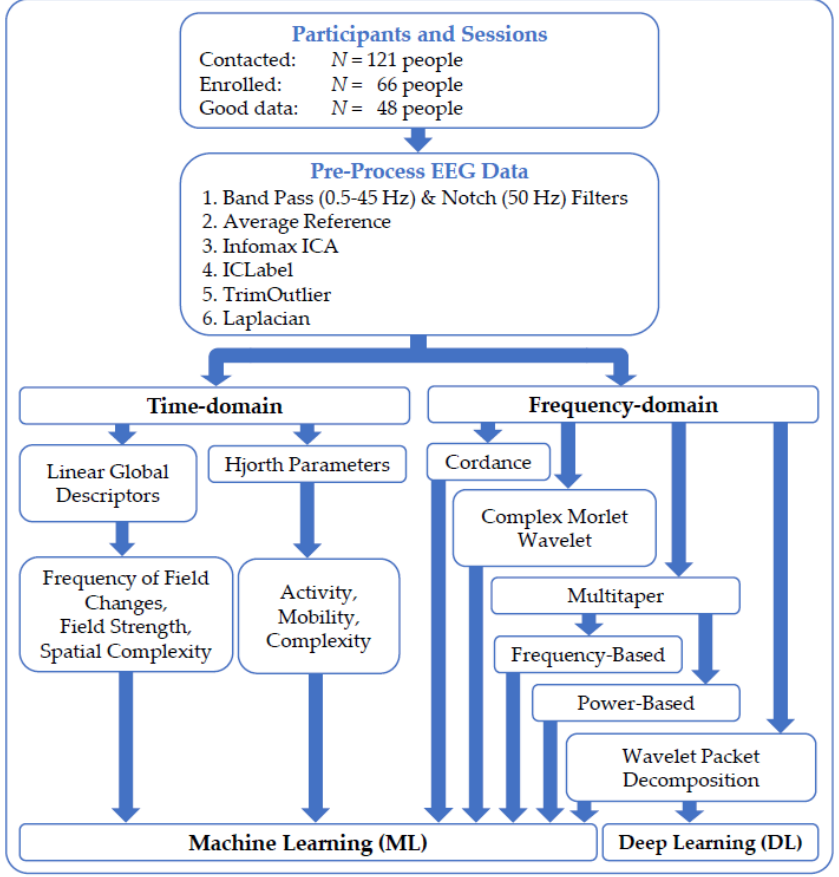
Figure 4. The data collection and pre-processing pipeline.